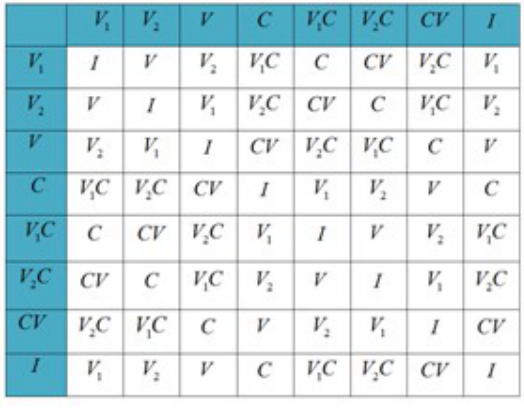
Figure 5. Group created with eight coin